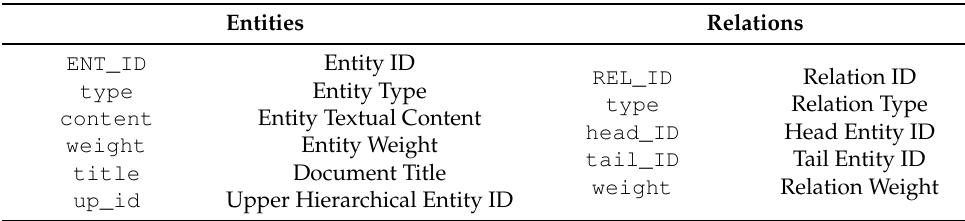
Table 1. Denotations of keys in metaknowledge dictionary.